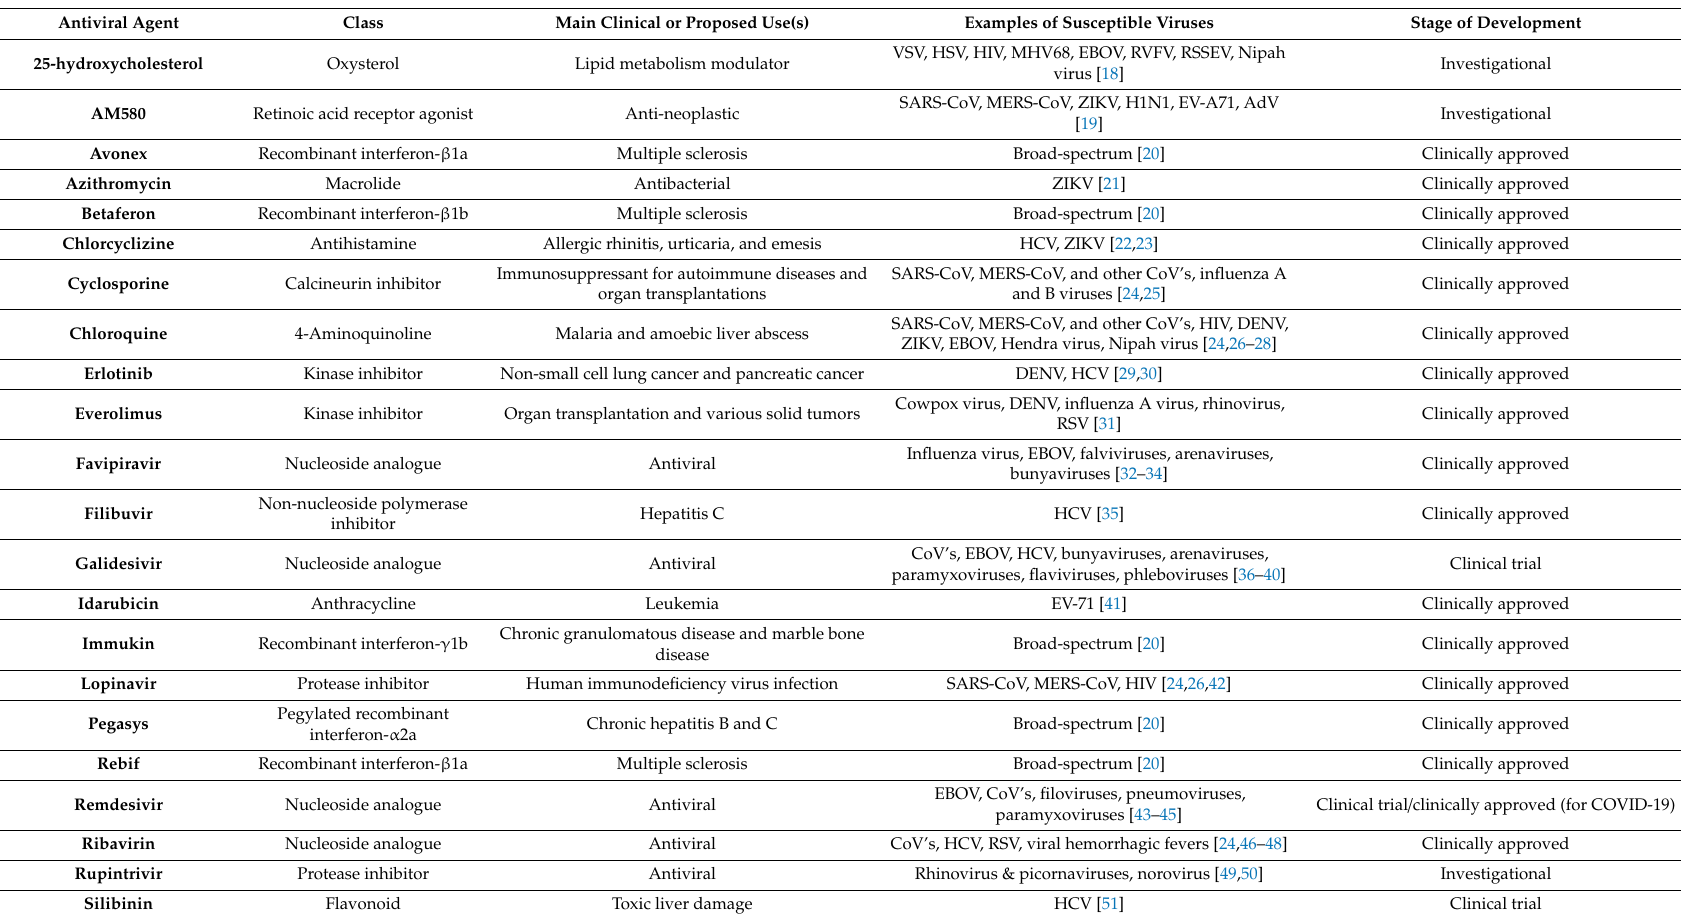
Table 1. Antiviral agents included in the primary screening in this